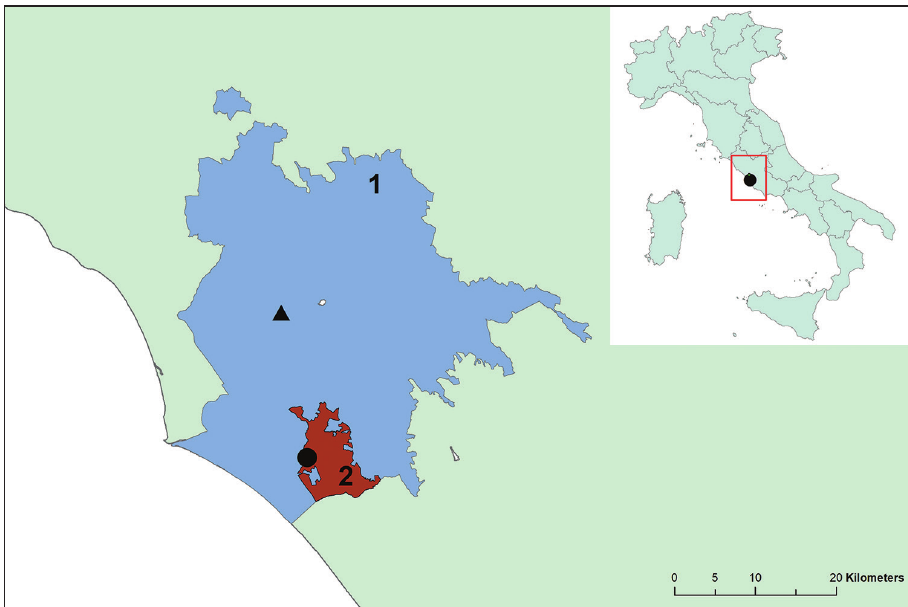
Figure 6. Occurrence of Trifolium latinum . The black circle marks the current population; the black triangle indicates the historical site. 1: Municipality of Rome; 2: Decima-Malafede Regional